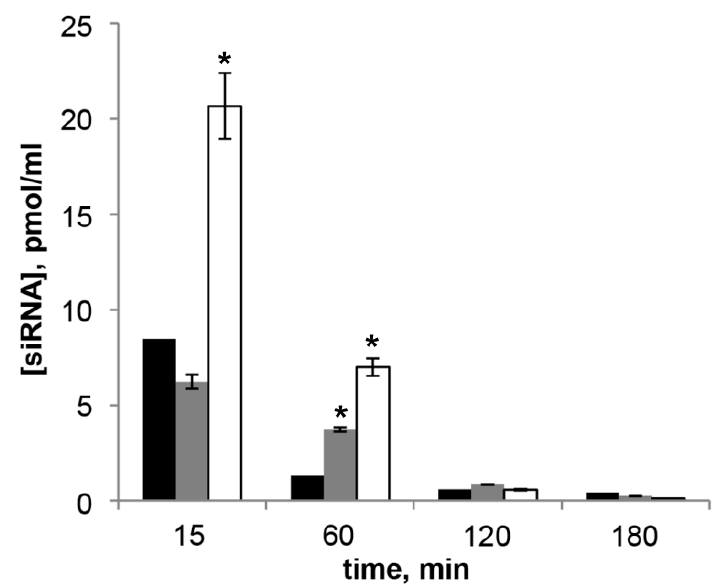
Figure 5. Concentration of siMDR measured by stem-loop PCR in blood plasma of CBA/LacSto mice 15–180 min after i.v. injection of L /siMDR (black bars), P800 /siMDR (grey bars) or P2000 /siMDR (white bars) lipoplexes formed at N/P = 4/1. The data represent means ± standard deviation (SD) ( n = 3). The differences between mean values for L and other preparations at the same N/P were considered statistically significant * p < 0.01 (Mann-Whitney U-test).